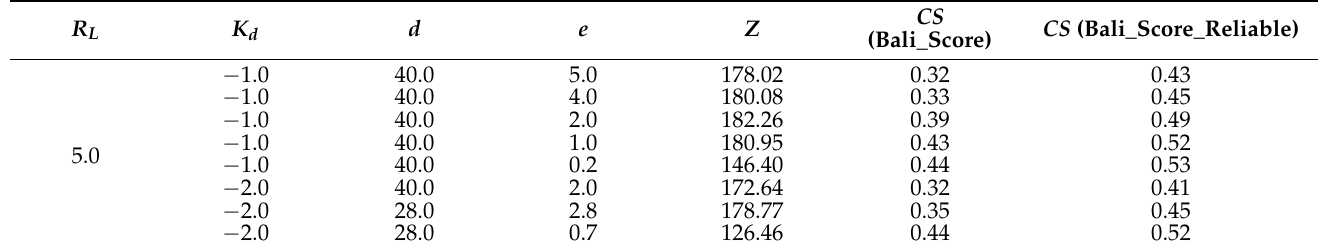
Table 1. Mean Z and CS values for BAliBASE protein families’ alignments produced by MAHDS with different K d , d , and e parameters.